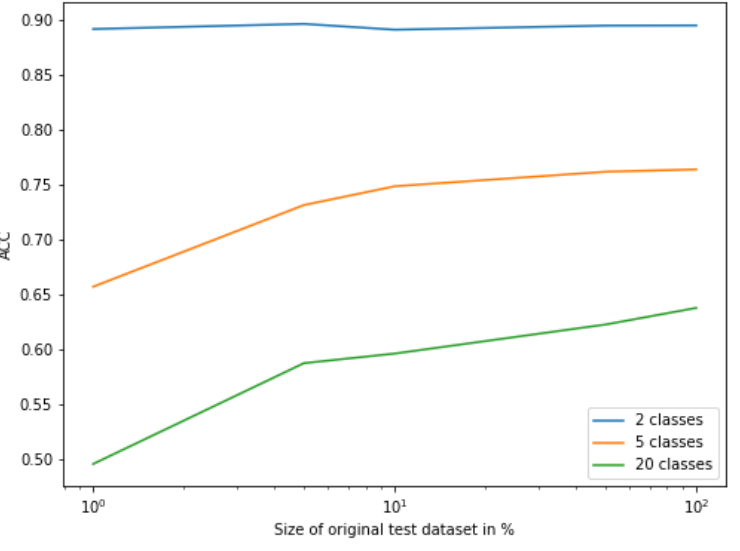
Figure 8. ACC as a function of the size of the original test